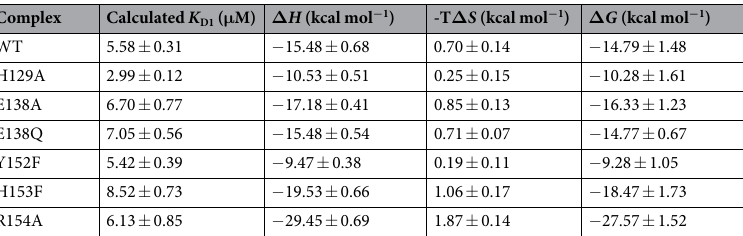
Table 2. Isothermal titration calorimetry measurements of SAM binding affinity to wild-type and mutant RlmH. The table reports standard deviations for three replicates (except for R154A mutant, n = 2). The thermodynamic parameters are displayed in Figure